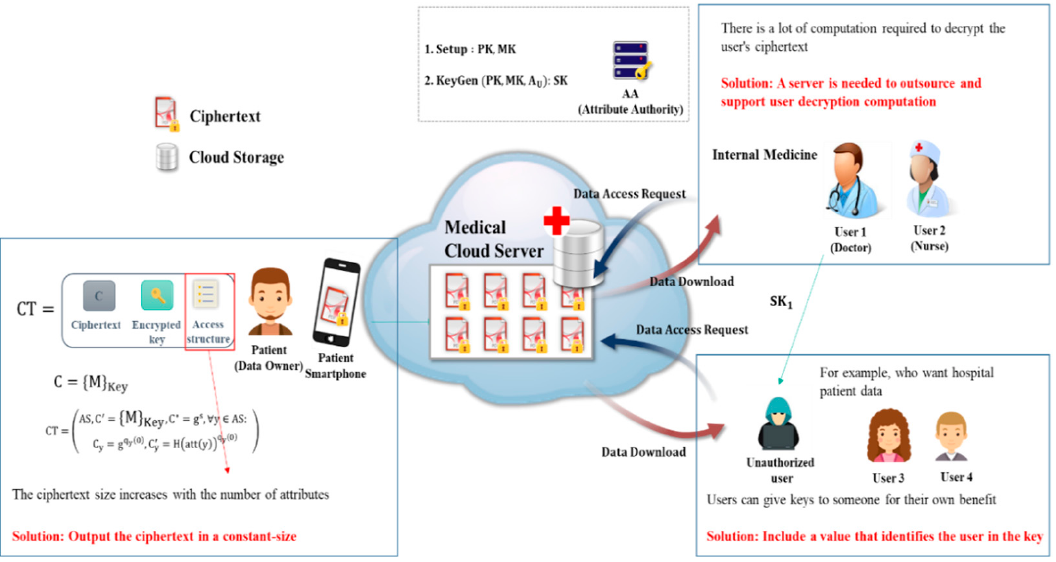
Figure 5. Problems that can occur in CP-ABE.